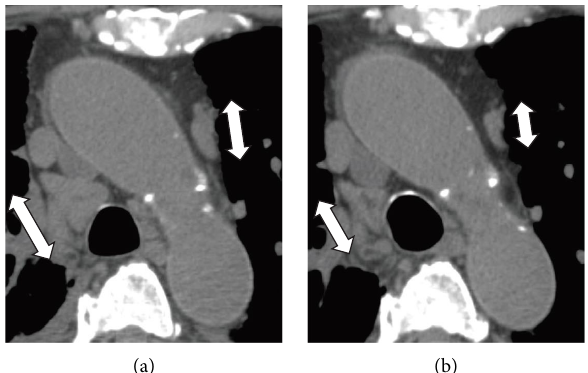
Figure 4: Radiological fndings. Computed tomography of the chest before (a) and after treatment (b). Periaortic and lung hilar lymph nodes (two-headed arrow) appear reduced in size.